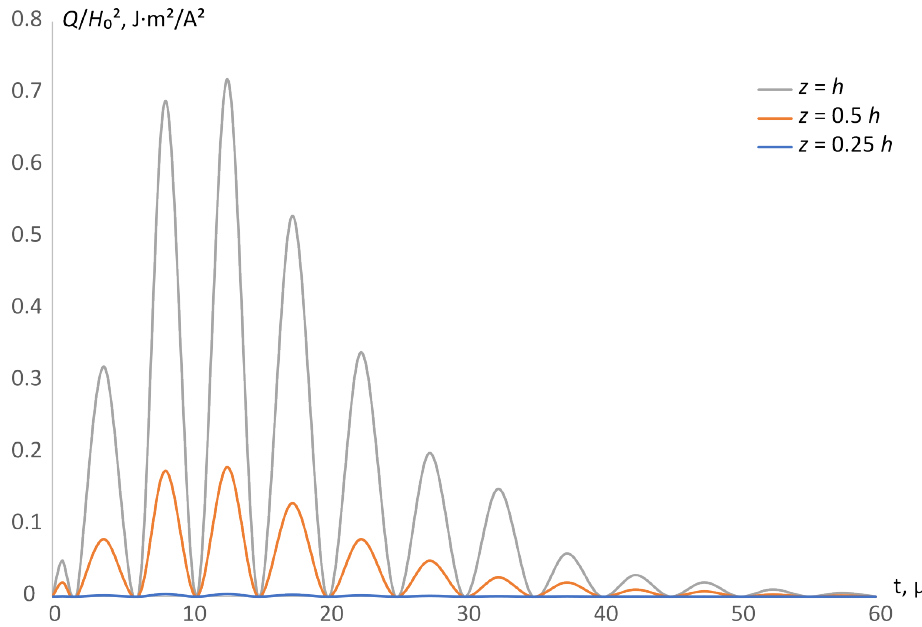
Figure 2. Thermal variation of Joule’s heat in the plate element at ω = 6.28 · 10 5 rad/s.